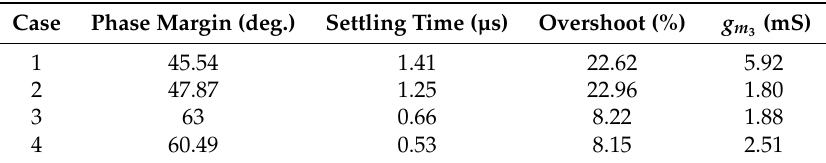
Table 3. Performance of the four design cases given in Table